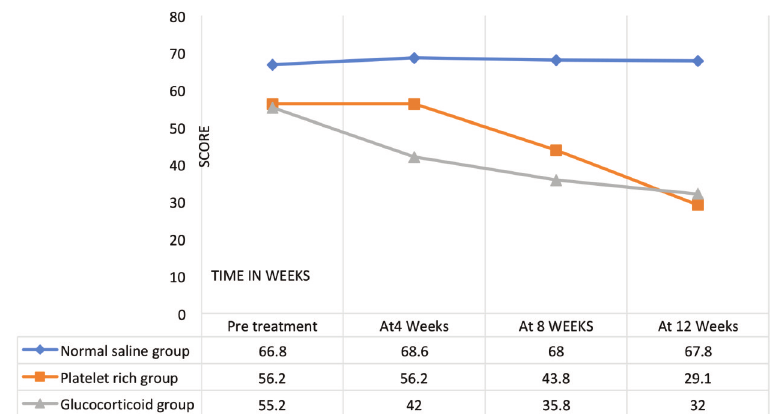
Comparison of DASH score, (pre -treatment and post infiltration of normal saline, l-PRP, glucocorticoid at follow-up visits of 4, Fig. 4: 8, and 12 weeks).